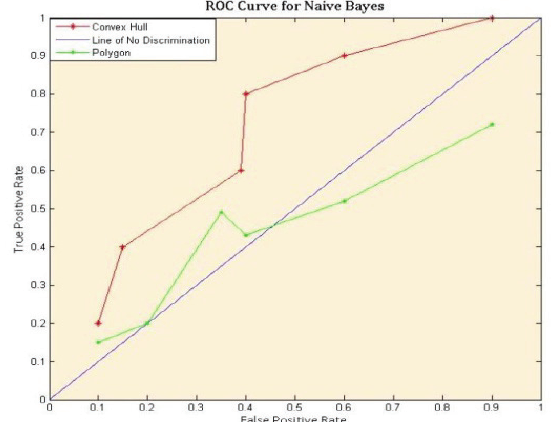
Fig. 19. ROC curve for Naïve Bayes’ Classifier